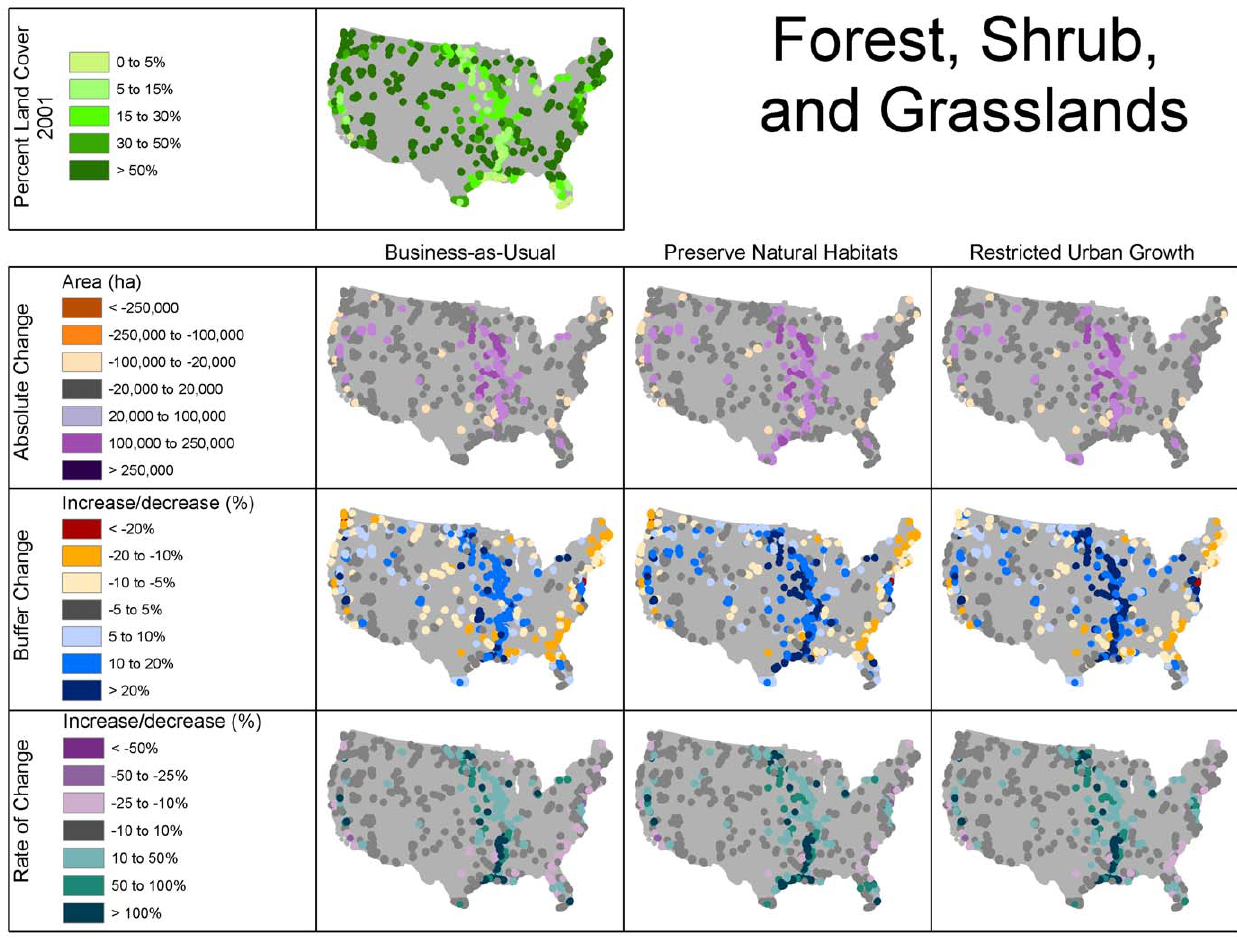
Figure 3. Initial land use and change in forest/range land use within 25 km of refuges under the different scenarios. Absolute change=change in area (ha), buffer change=percent of buffer that changes use, and rate of change=percent growth.